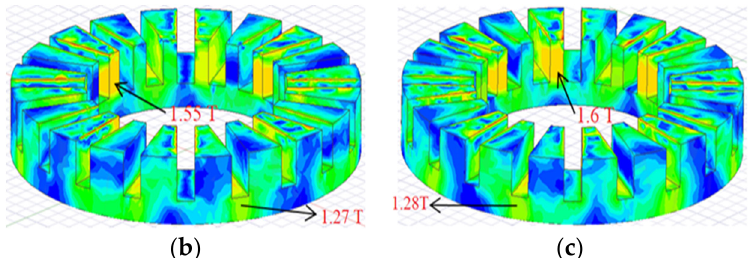
Figure 16. Flux density distribution of the proposed generator. ( a ) Symmetrical position, ( b ) lower side of the stator core, ( c ) upper side of the stator core.